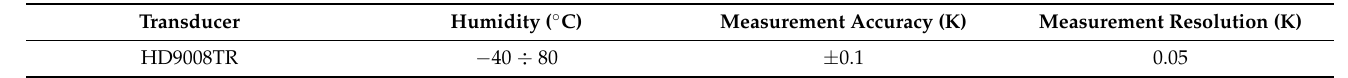
Table 4. Technical specification of the meteorological